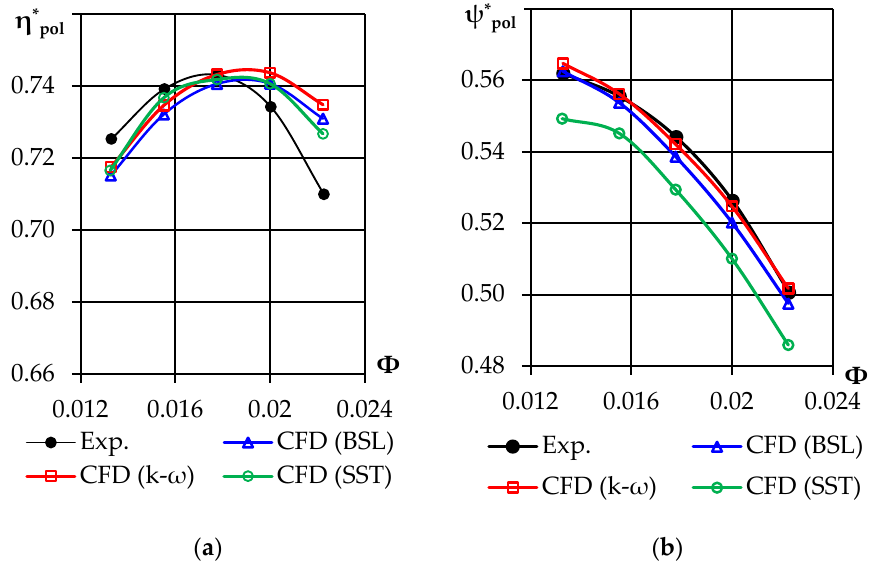
Figure 4. Results of the study of the turbulence model influence on the results of modeling the Q-482 model stage: ( a ) Polytropic efficiency on total parameter; ( b ) Polytropic head coefficient on total parameter.